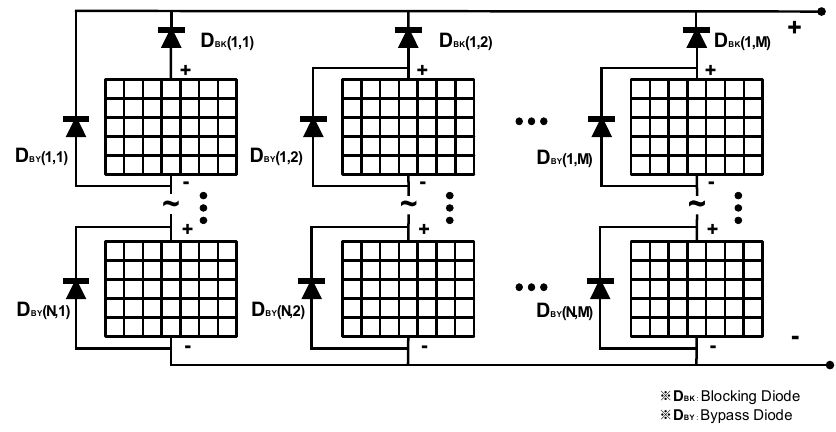
Figure 2. PV Array integrated with a bypass and a blocking diode.